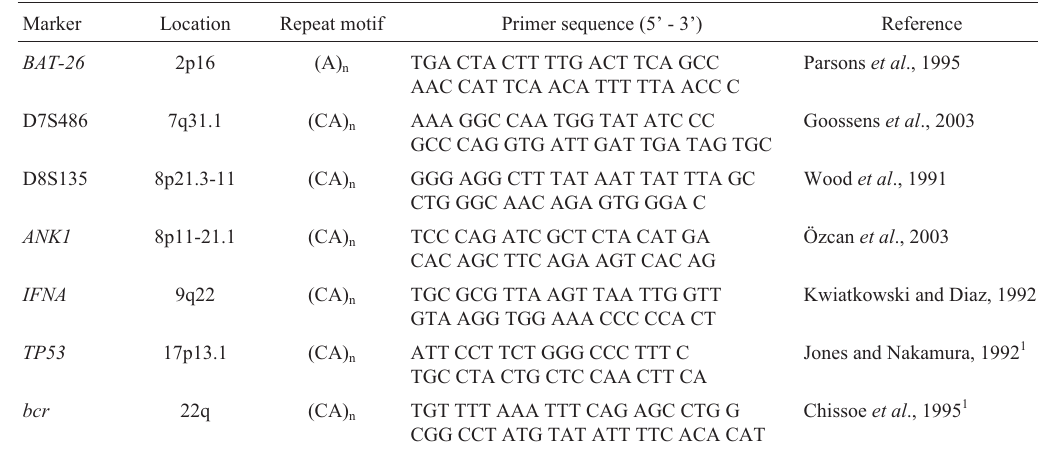
Table 1 - Microsatellite